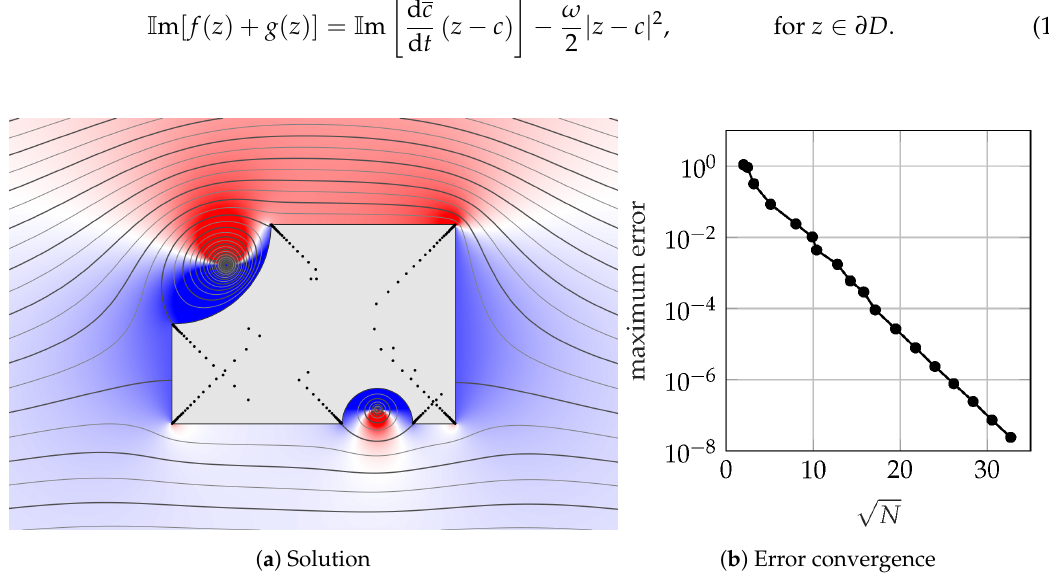
Figure 3. Uniform flow past the polycircular domain from [52] with embedded point vortices. The lines are the streamlines and background color is the horizontal perturbation velocity. The black dots represent the prescribed poles of the rational function. The solution converges to five digits of accuracy in 0.8 s and 8 digits in 6